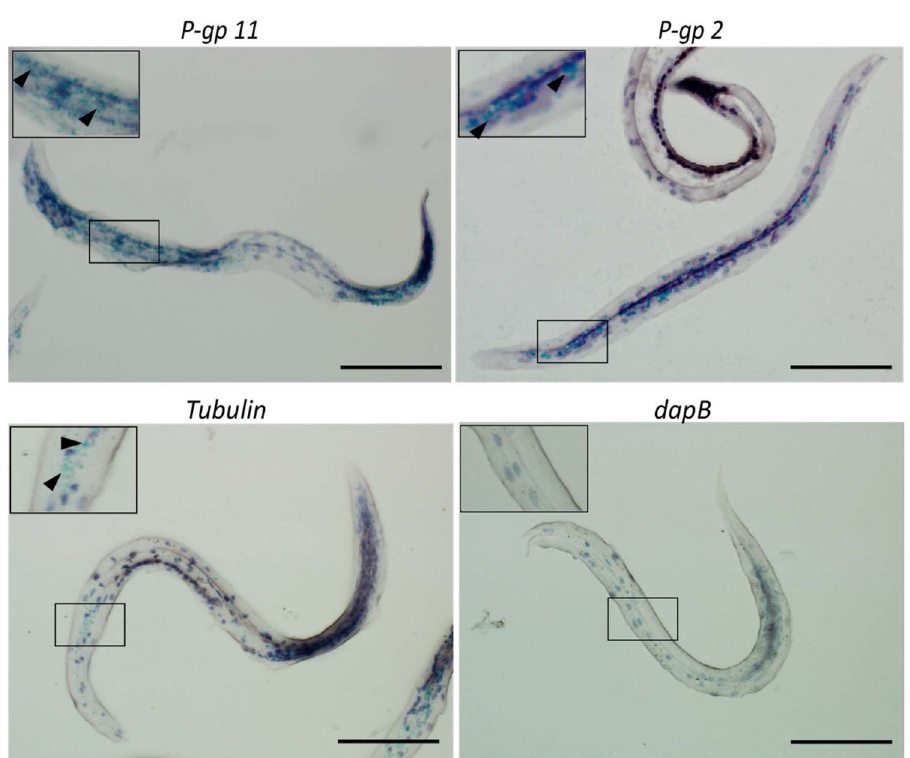
Figure 8. Expression of P-gp mRNA in T. canis larvae in situ detected by RNAscope assay. Small box indicates location of magnified inset. Hybridization of probe (green punctates) is indicated by arrow heads. T. canis β-tubulin (positive control) and Bacillus subtilis dapB (negative control) were probed in parallel. Scale bar = 50